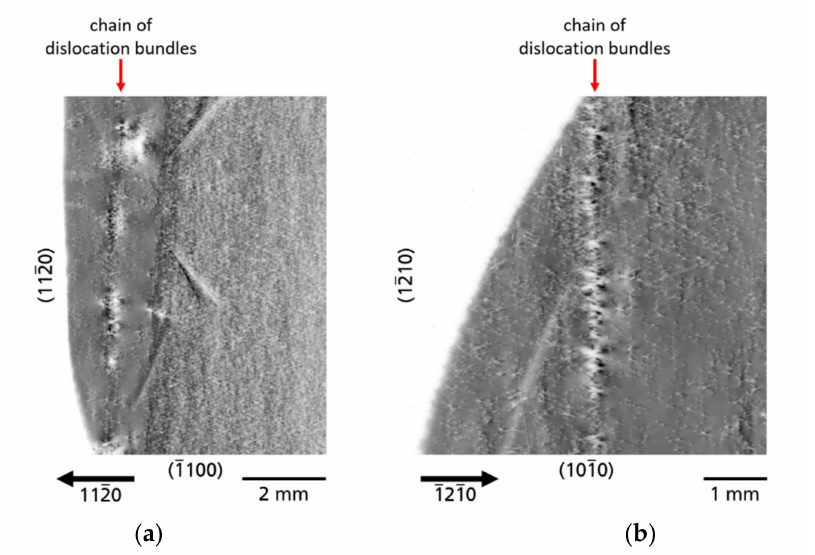
Figure 11. Single dislocation bundles (DBs), which have formed independently of TDD in the surrounding matrix; ( a ) matrix with higher TDD; ( b ) matrix with intermediate TDD; and ( c ) matrix with very low TDD.